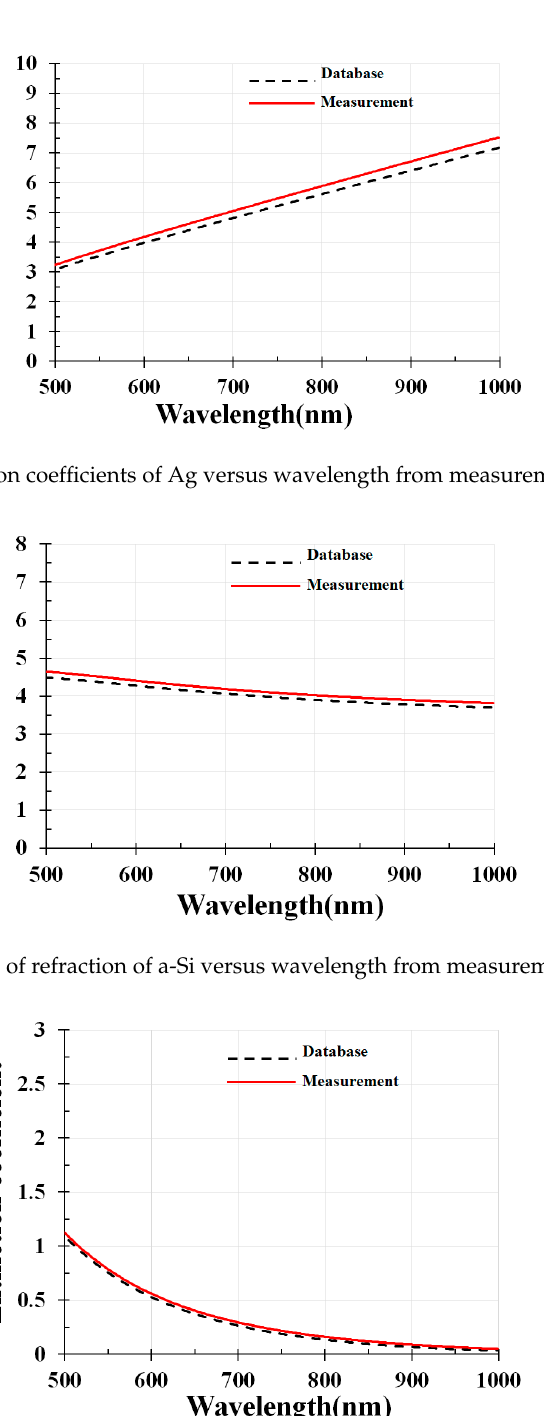
Figure A1. The indexes of refraction of Ag versus wavelength from measurement and database.